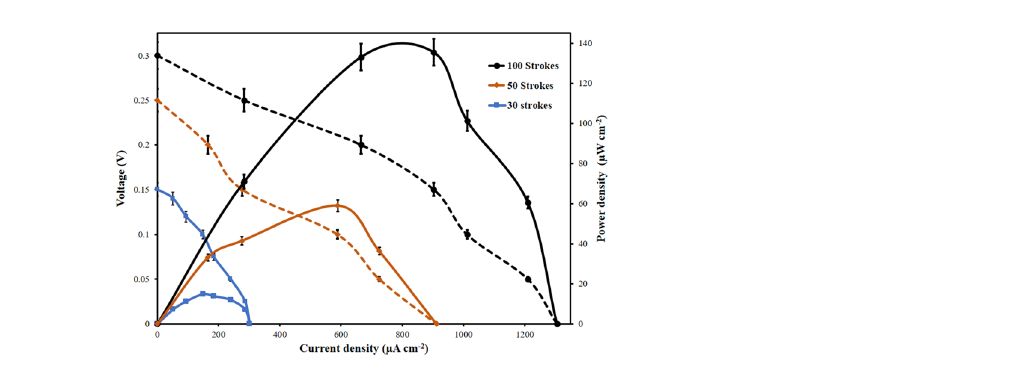
Figure 4. Polarization performance of microfluidic fuel cell with automated pencil electrodes at 30, 50, and 100 strokes with standard deviation (n =